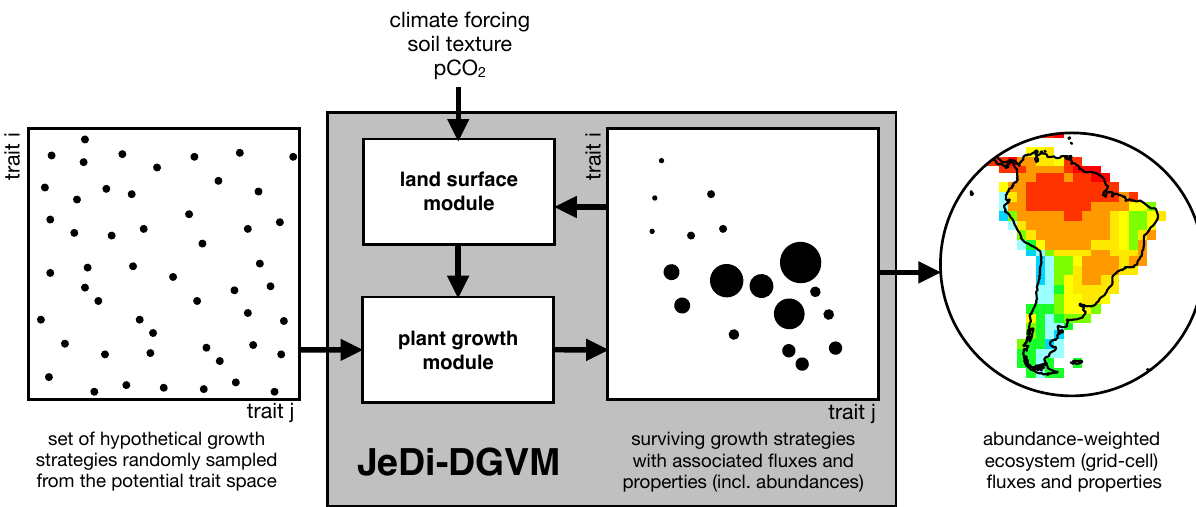
Fig. 1. Schematic diagram of the JeDi-DGVM modelling approach. The model generates a large number of hypothetical plant growth strategies, each defined by 15 functional trait parameters that characterize plant behaviour with regards to carbon allocation, phenology, and ecophysiology. The trait parameter values are randomly sampled from their full observed or theoretical ranges. The plant growth module simulates the development of the plant growth strategies (independently and in parallel) based on fundamental ecophysiological processes (e.g. photosynthesis, respiration, allocation, phenology, and turnover). The environmental conditions of each strategy are provided by the land surface module, which simulates canopy interception, infiltration, evaporation, root water uptake, and runoff using daily meteorological forcings of downwelling shortwave and longwave radiation, air temperature and precipitation. Land surface parameters (e.g. leaf area index, surface albedo, and rooting depth) derived from the carbon pools and trait parameters of each plant growth strategy affect its simulated land surface hydrology and, consequently, its net primary productivity (NPP), i.e. its supply of assimilates. Functional trade-offs and the climatic conditions in each grid cell constrain the range and relative fitness of the surviving growth strategies (i.e. those that are able to maintain a positive balance of stored assimilates). The fluxes and properties of the surviving plant growth strategies are averaged, weighted by their relative biomasses, at each time step and grid cell to produce aggregated ecosystem-scale output variables. The aggregated litter fluxes form the input for an additional module (not shown) for simulating soil carbon dynamics and heterotrophic respiration.